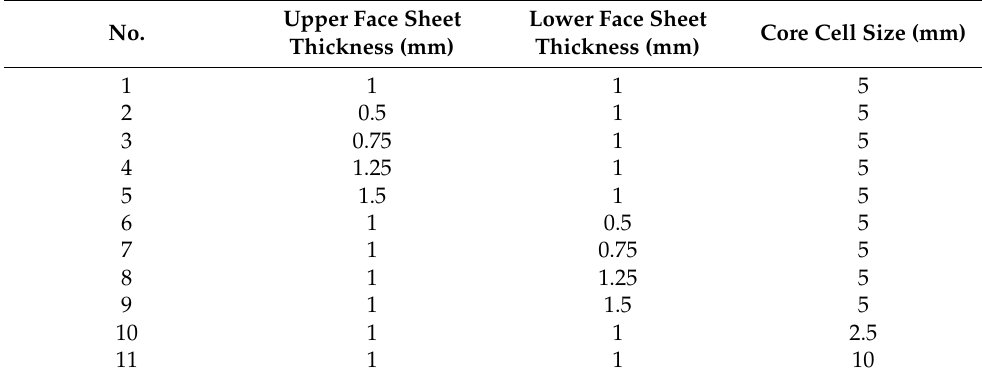
Table 3. AFSP with different geometrical